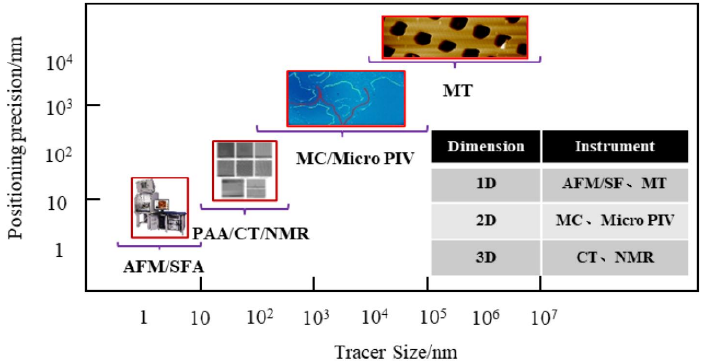
Figure 2. Classification of physical models for microscopic visualization of multiphase seepage laws [22].